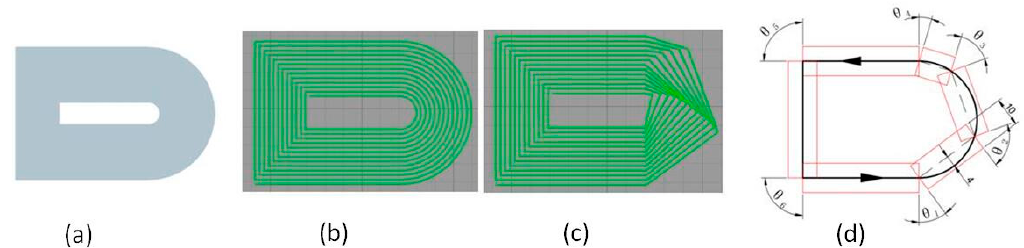
Figure 5. ( a ) The printed model, ( b ) the path of the nozzle, ( c ) the path of the pressure roller and ( d ) the path of the nozzle and pressure roller in the outermost circle of the model.